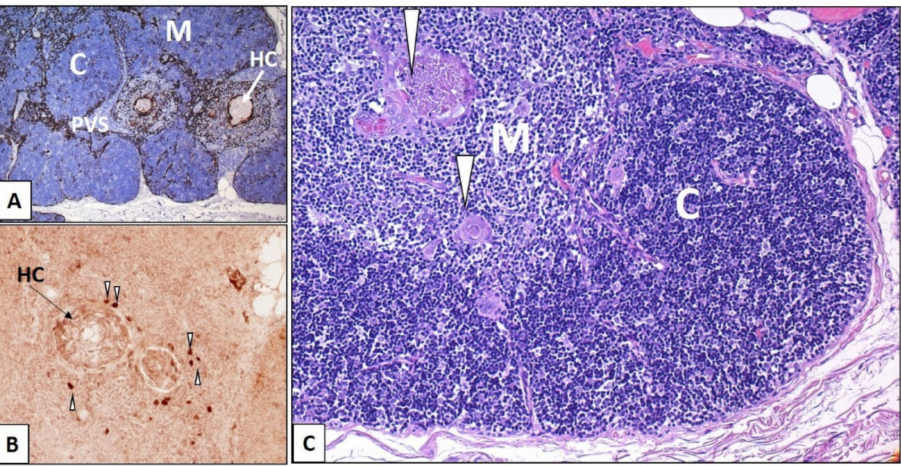
Figure 1. Main cellular compartments of the thymus. The figure shows the main cellular components of the thymus, epithelial and lymphoid, and their organotypic organization. Staining with CK19 outlines the thymic compartments, Cortex, Medulla and Perivascular spaces bordered by an epithelial cell lining; Hassall’s corpuscle can also be observed ( A ); in ( B ) Aire nuclear staining (white arrows) of cells around Hassall’s corpuscles (HCs) (black arrow) in the thymic Medulla. In ( C ) the overall thymic structure is shown in H&E: in the thymic Cortex—(C), epithelial cells (cTEC) constitute a network which is hardly seen at low magnification, where thymocytes are embedded; in the medulla (M) scattered mTEC establish a network where mature lymphocytes are embedded; HCs are also present, formed by concentric epithelial swirls (white arrows). A and B: courtesy of Prof. Marx and of Prof. Ströbel, Mannheim/Göttingen, Germany. HC: Hassall’s corpuscle; M: medulla; C: cortex; CMJ: corticomedullary junction; PVS: perivascular